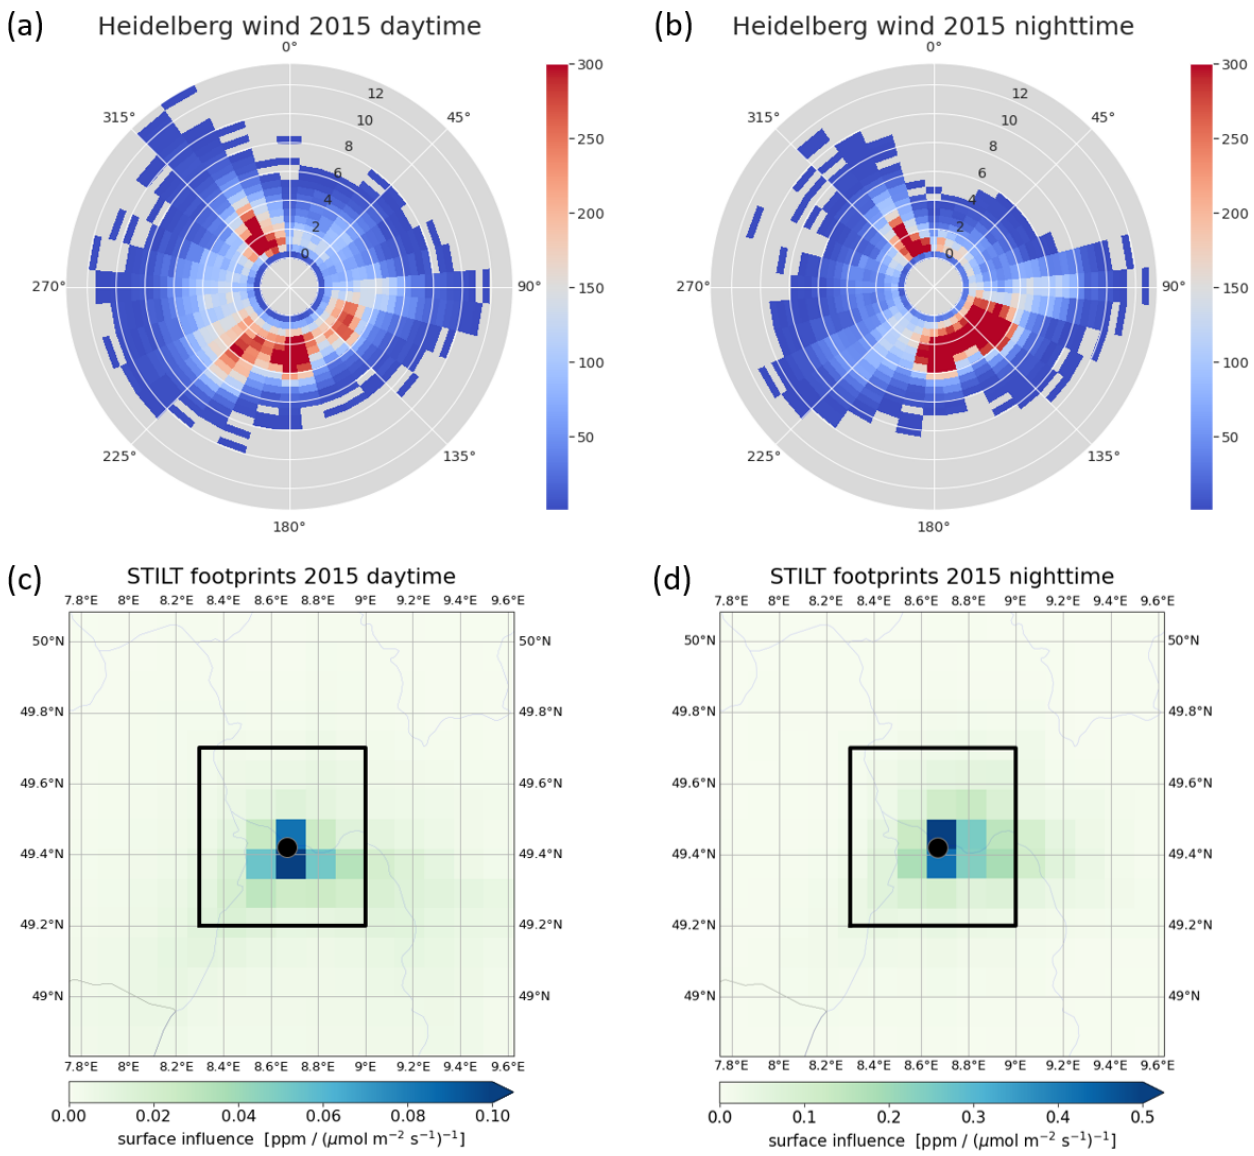
Figure 2. ( a, b ) Wind distributions (5min mean values, wind velocity in ms − 1 displayed on the radius) in 2015 measured on the roof of the Institute of Environmental Physics building at a height of 37ma . g . l . Daytime (a) and nighttime (b) wind distributions are similar. (c, d) Annually aggregated surface influences of potential emissions for 2015 ( c : daytime and d : nighttime). Note the different scales for day and night, indicating an approximately 5-fold sensitivity of emissions to concentrations observed at 30ma . g . l . during nighttime compared to daytime. The black rectangle marks the “small” influence area with Heidelberg in the approximate centre (black